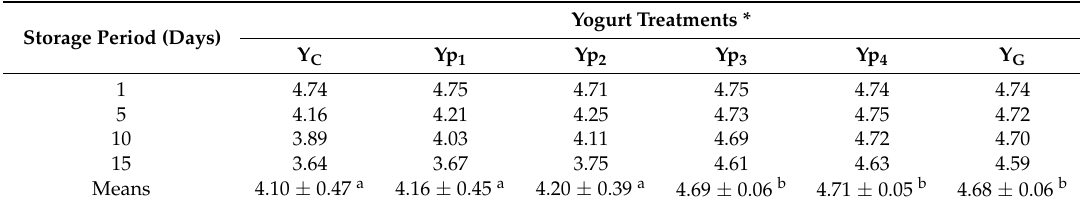
Table 5. Mean values of pH in yogurt manufacturing at 5 ◦ C for 15 days.